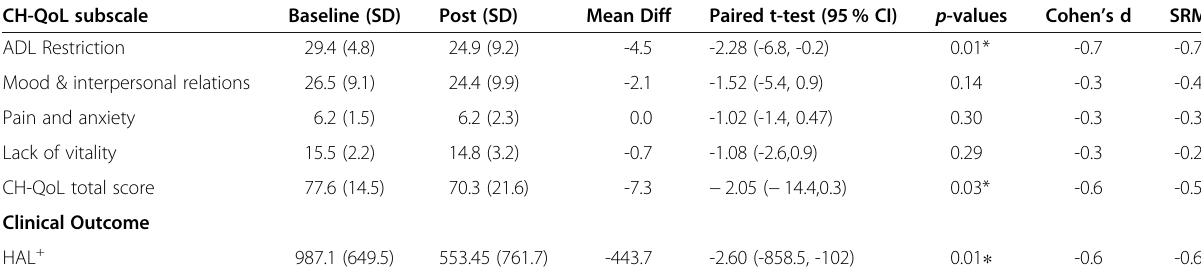
Table 3 CH-QoL sensitivity to change for the patients with cluster headache who underwent ventral tegmental area deep brain stimulation (VTA-DBS).